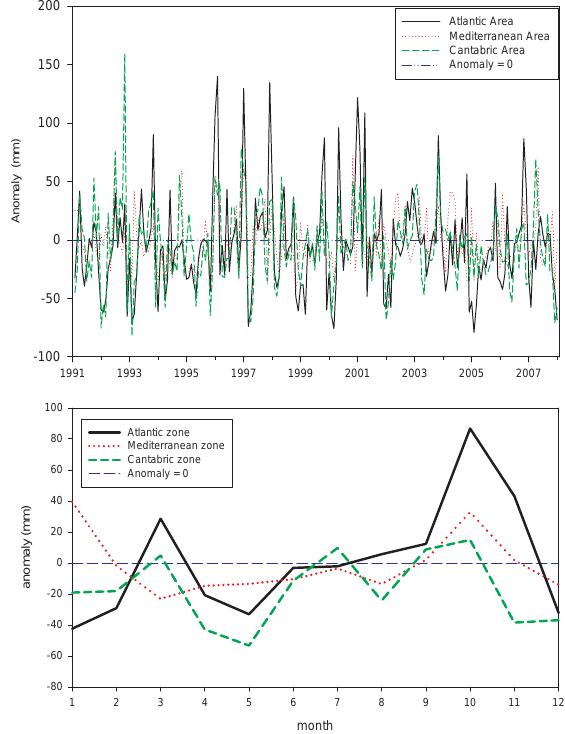
Fig. 2. Time evolution of precipitation anomalies in the Atlantic, Cantabric and Mediterranean zones of Iberia: (a) from 1991 to 2008; (b) the year